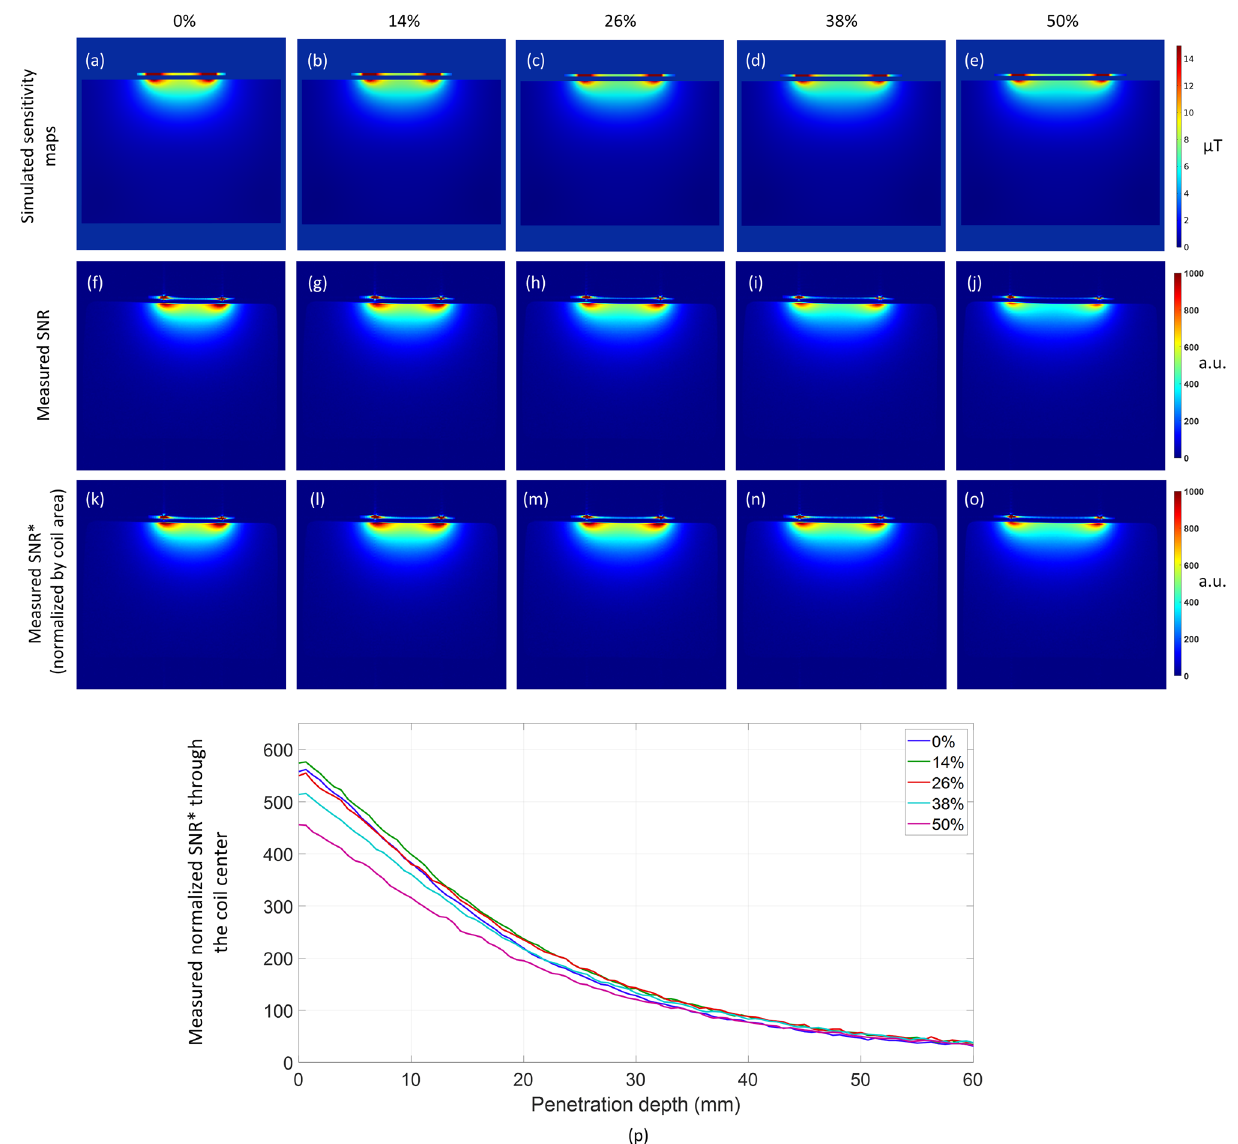
Figure 4. Phantom/in vitro stretching tests with the proposed coil. ( a – e ) Simulated sensitivity (B1- field) profiles (normalized to 1 W input power) and ( f – j ) measured SNR maps at the central axial slice with the numbers on top indicating the percentage of coil stretch. ( k – o ) Measured SNR maps normalized to the coil area demonstrating relative SNR stability with stretching. ( p ) Normalized SNR* measured through the center of the coil into the